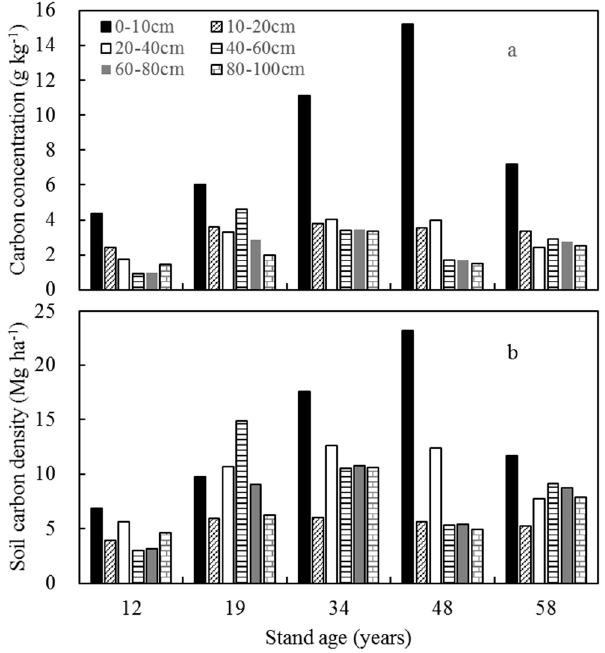
Figure 3. Distribution patterns of the carbon concentration ( a ) and carbon density ( b ) at different soil depths in the 12-, 19-, 34-, 48-, and 58-year-old Mongolian pine ( Pinus sylvestris L. var. mongolica Litv.) stands.